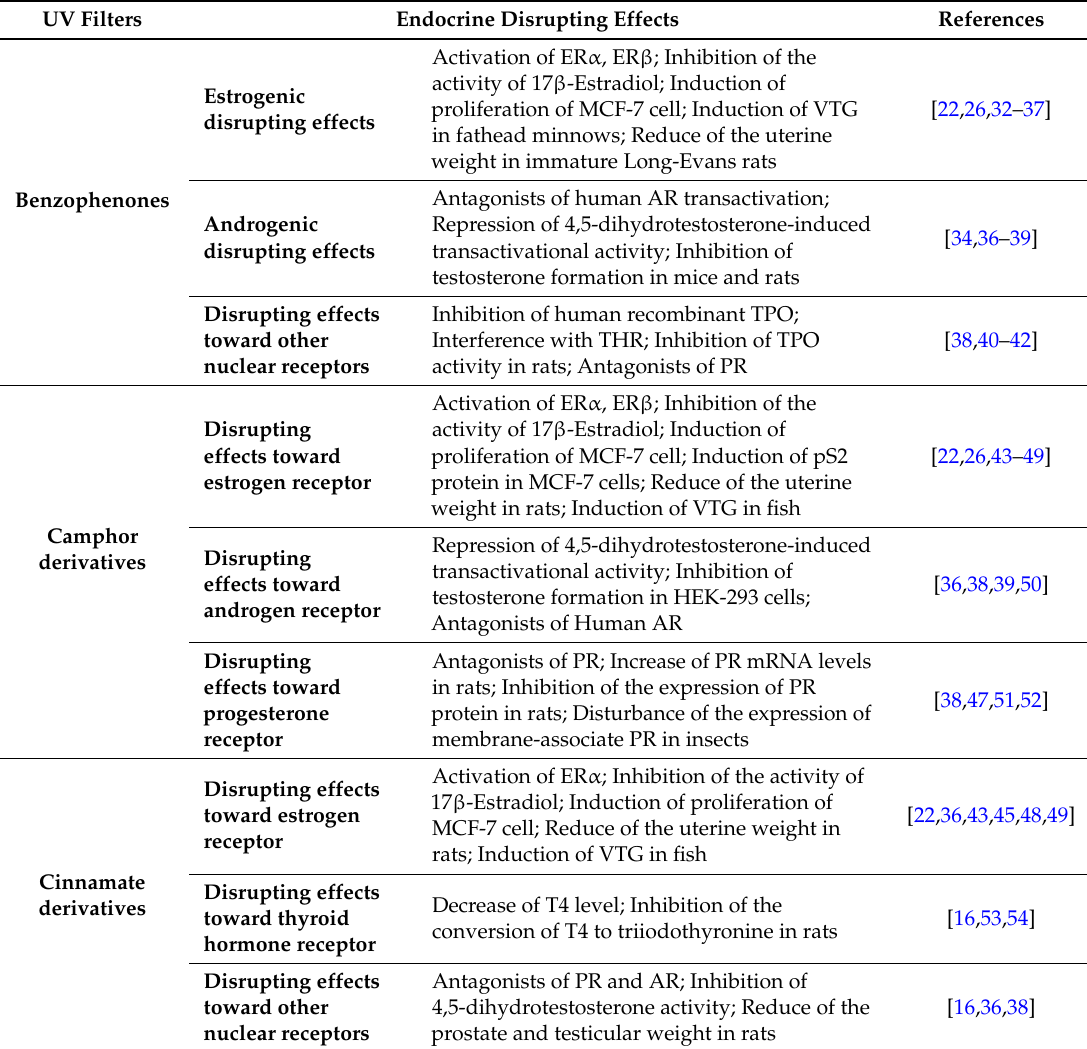
Table 2. Endocrine disrupting effects of the commonly used UV